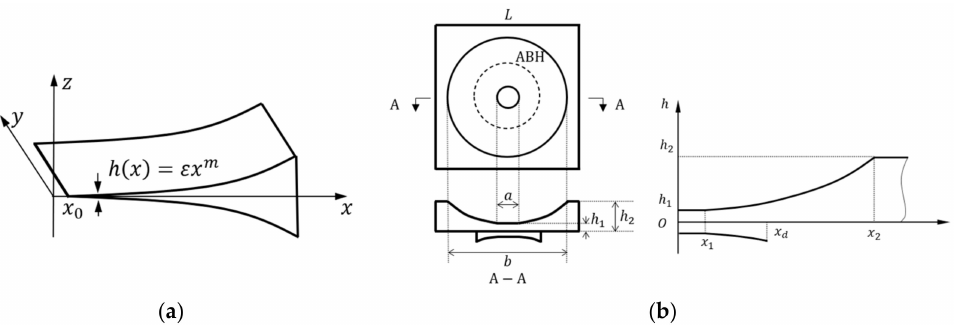
Figure 13. ( a ) A symmetrical one-dimensional ABH structure, ( b ) A two-dimensional ABH indenta- tion with varying thickness damping layers.